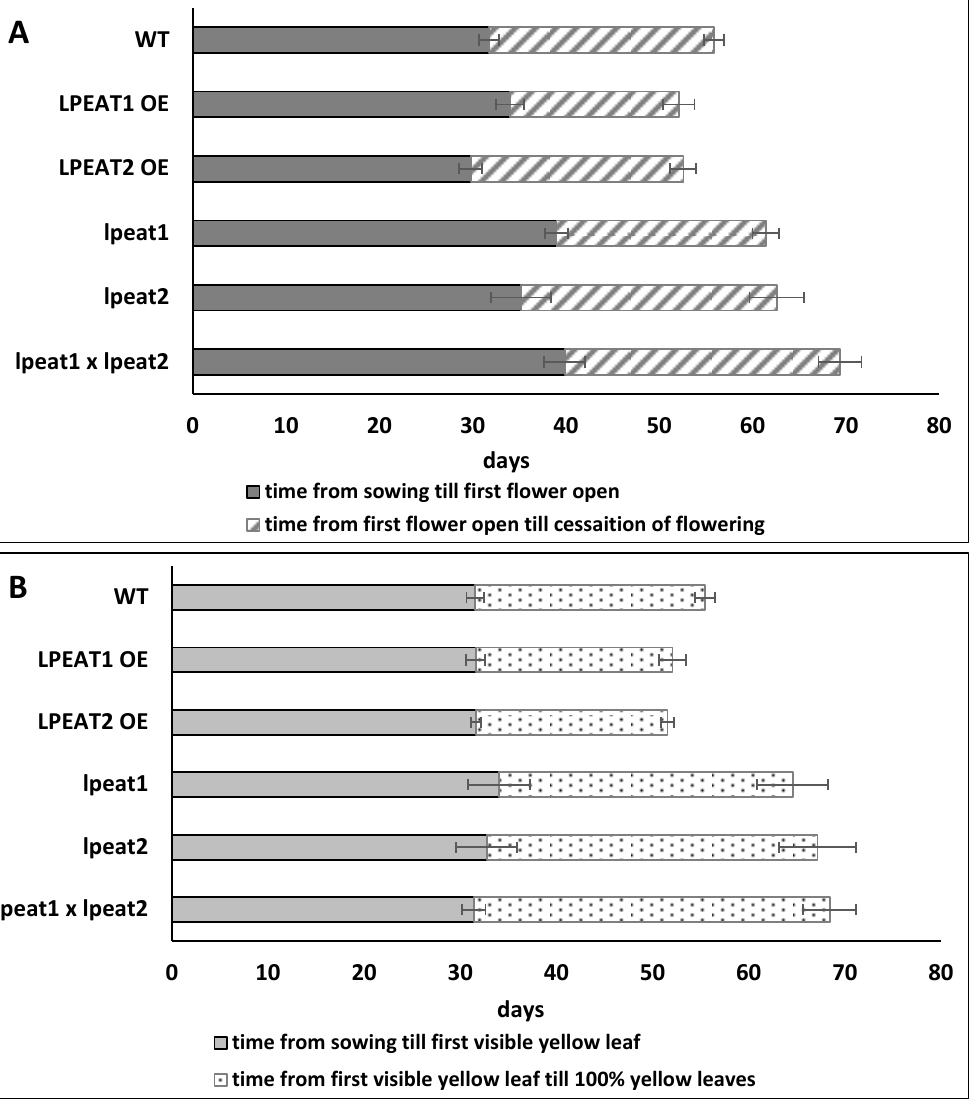
Figure 10. Length of major stages of life cycle of Arabidopsis plant of wild-type, lpeat1 mutant, lpeat2 mutant and lpeat1 lpeat2 double mutant as well as LPEAT1 and LPEAT2 overexpressors growth under standard conditions. Panel ( A ) represents the flowering time. Panel ( B ) represents rosette senescence of A. thaliana. Presented are average values and standard deviation ( n ≥ 3).